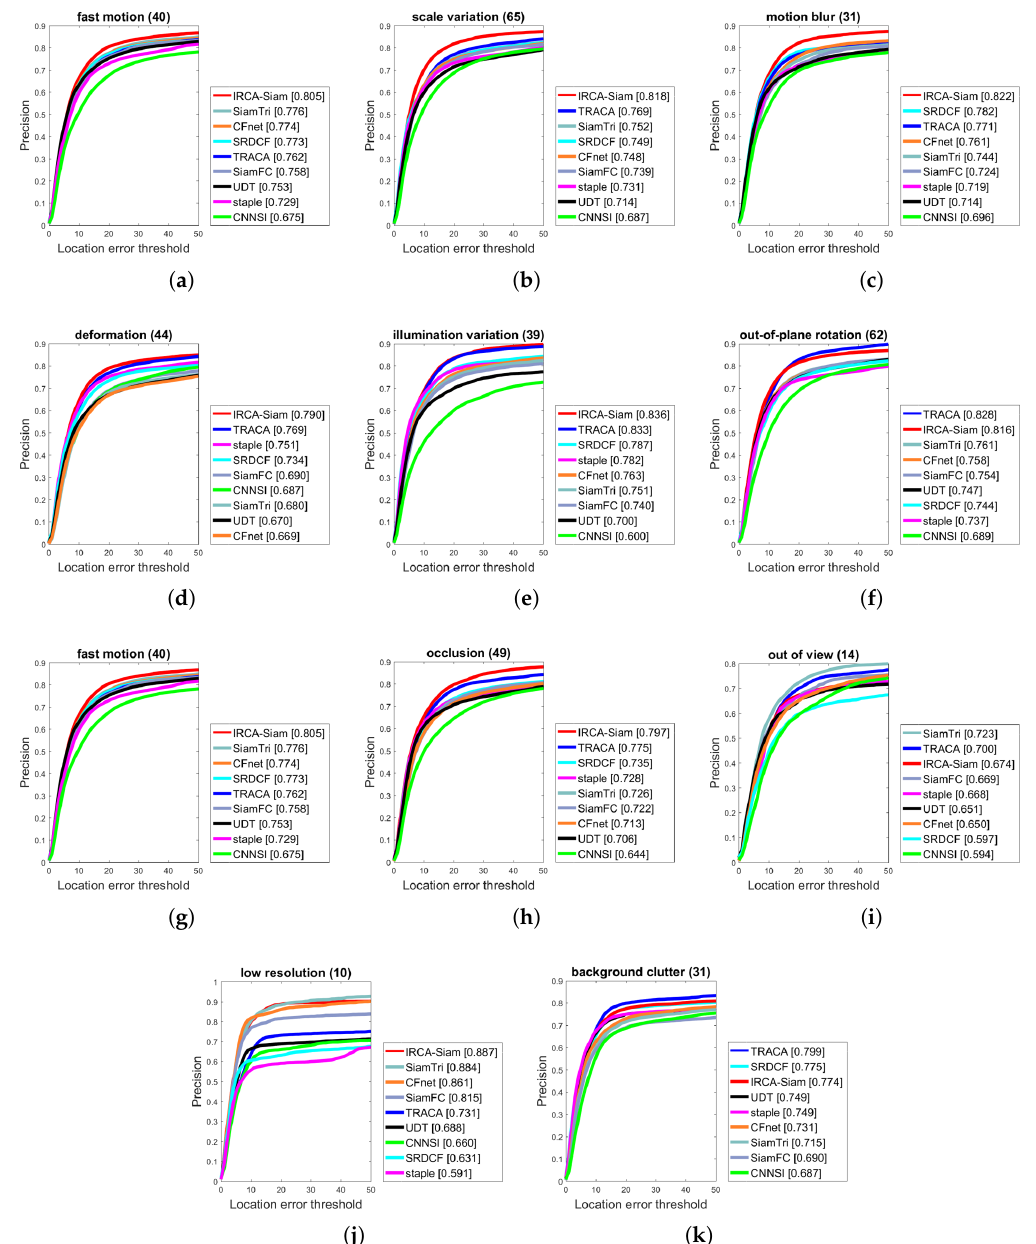
Figure 5. Precision plots over OTB2015 for different challenges such as ( a ) fast motion, ( b ) scale variation, ( c ) motion blur, ( d ) deformation, ( e ) illumination variation, ( f ) out-of-plane rotation, ( g ) fast motion, ( h ) occlusion, ( i ) out-of-view, ( j ) low resolution, and ( k ) background